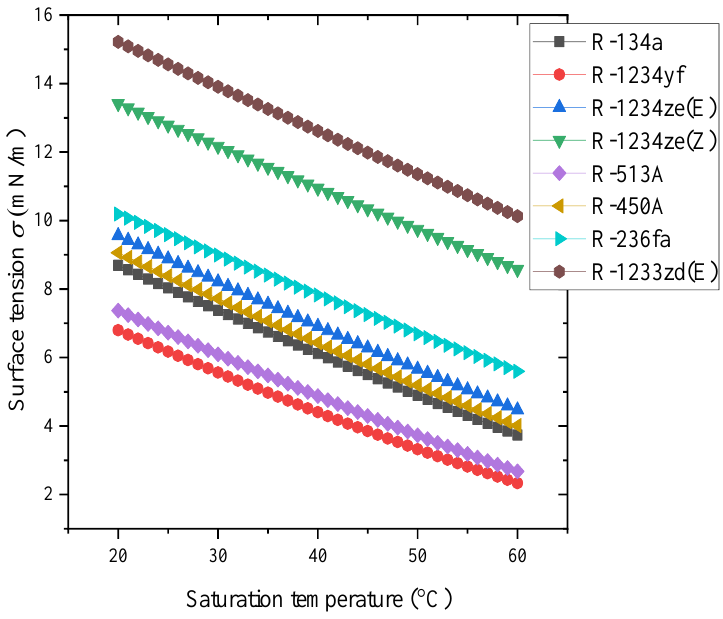
Figure 22. Saturation temperature versus surface tension of alternatives to R-134a [1].